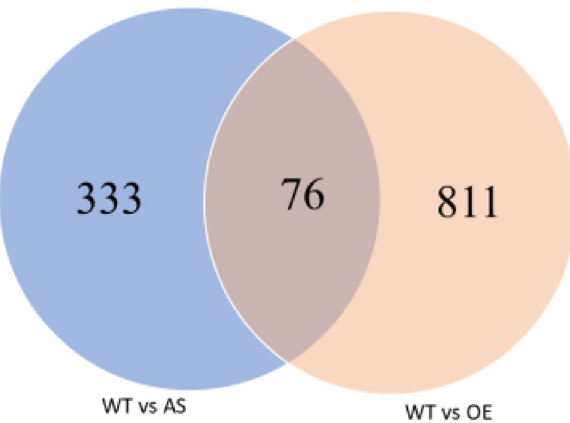
Figure 4. Venn diagram of different expression genes.